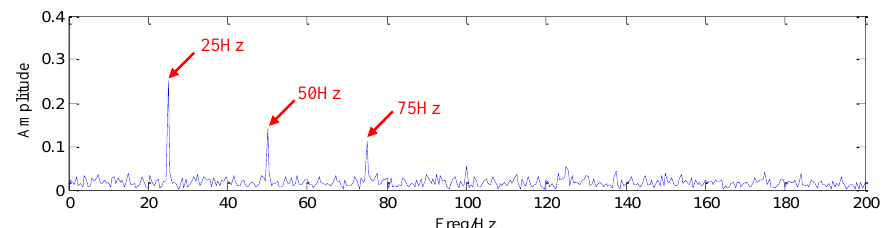
Figure 11. Filtering result of the simulated signal.